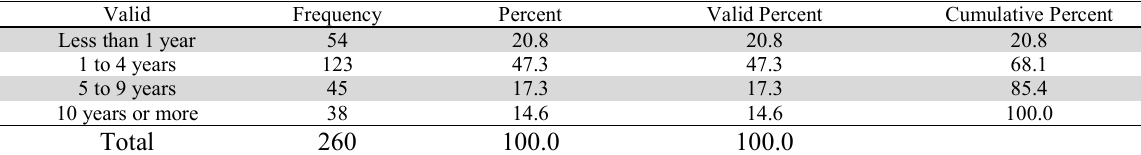
Descriptive statistics of Duration of